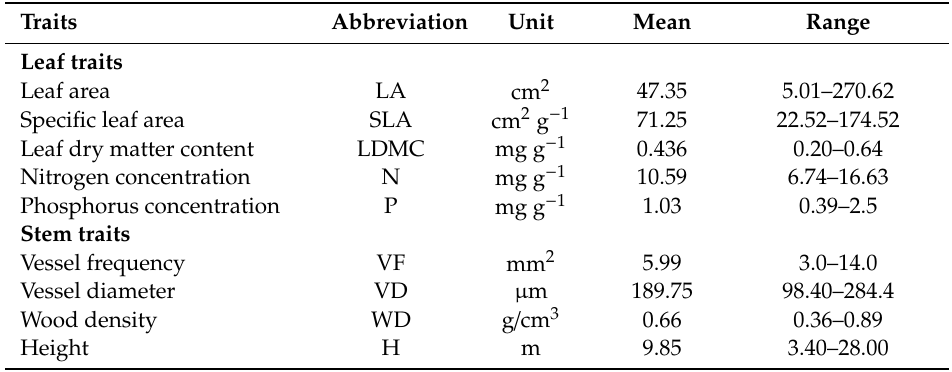
Table 2. Leaf and stem functional traits with mean standard and range of 9 functional traits of 275 oak